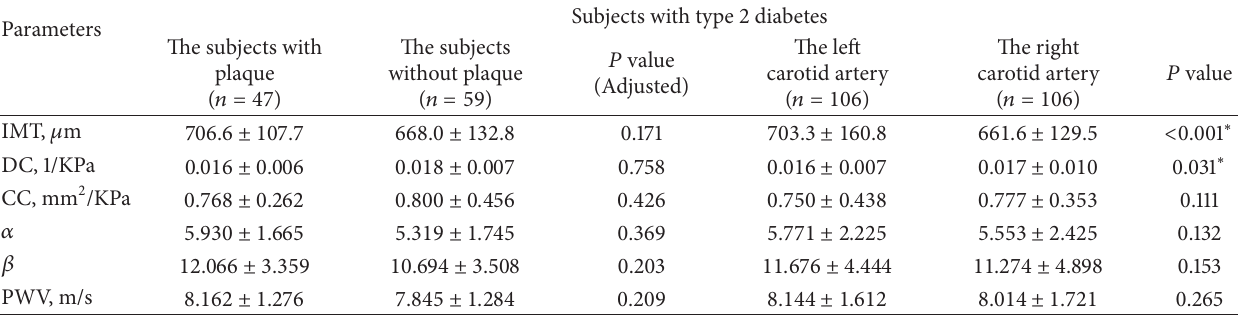
Table 3: Carotid IMT and carotid arterial stiffness in subjects with type 2 diabetes.